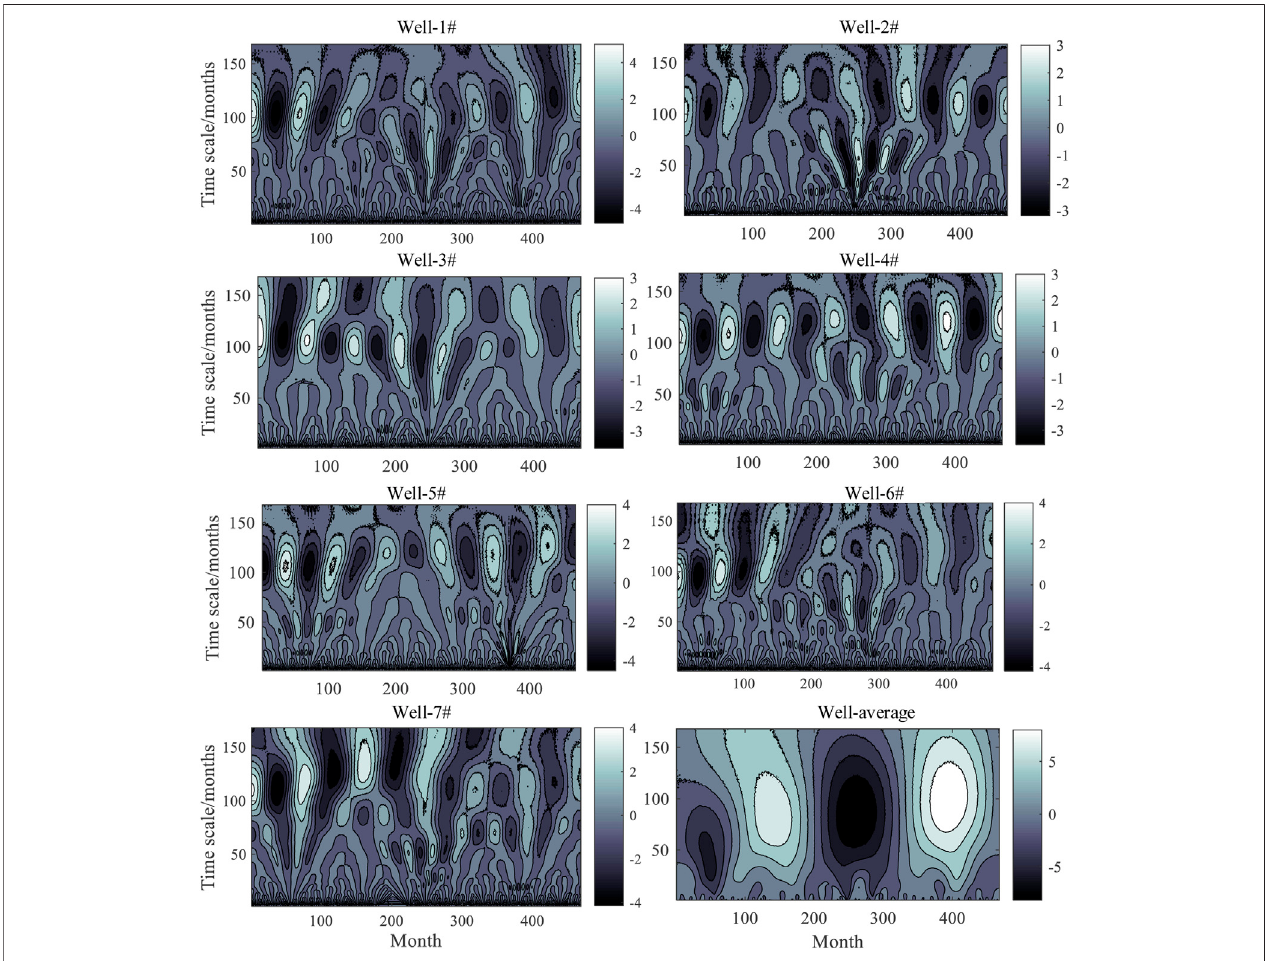
FIGURE 5 | Contour plot of the real part of the wavelet coef fi